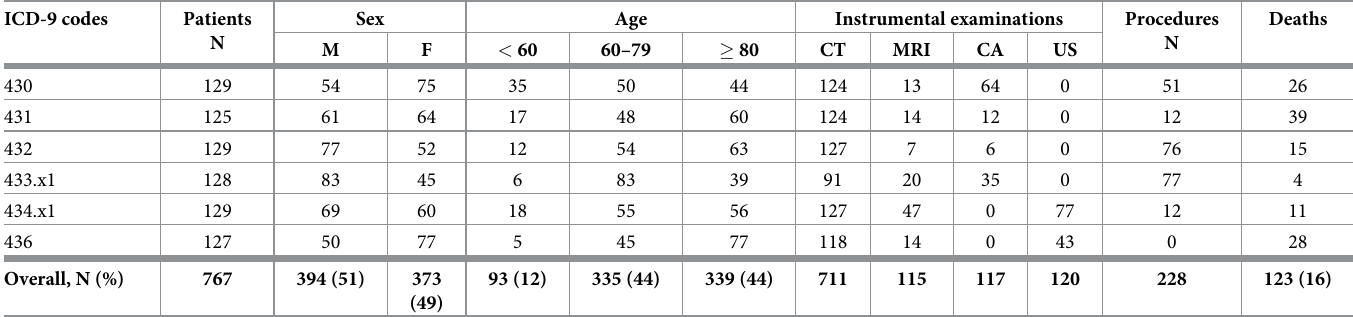
Subarachnoid hemorrhage. We identified a cohort of 294 patients with subarachnoid hemorrhage (ICD-9 430), from which we extracted a sample of 130 cases, of these 129 clinical charts were analysed (one clinical chart was not available). Table 2 shows the basic characteristics of the patients with subarachnoid hemorrhage. The majority of patients were females (58%). Most patients (73%) were > 60 years. Instrumental examinations performed for the diagnosis included computed tomography (CT) of the head for most patients, followed by arteriography of cerebral arteries, and magnetic resonance (MRI). Forty percent of patients underwent intracranial or neck vessels surgical procedures. Twenty percent of patients died during hospital stay.